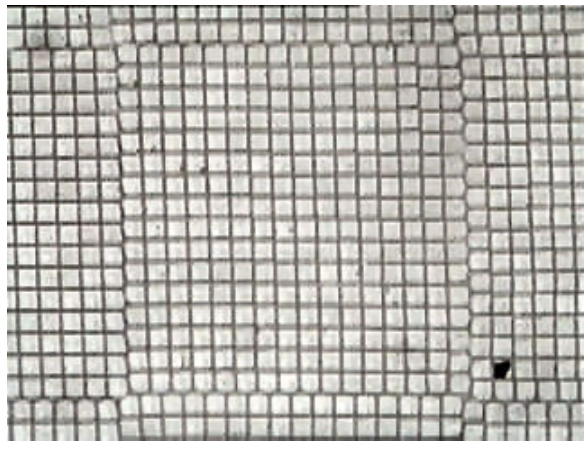
Fig. 6 . Optical microscope image of the prototype MCP optic showing the channel structure. Fig. 6. Optical microscope image of the prototype MCP optic show- ing the channel structure. The channel side length is 84 ± 2 µ m. The channel side length is 84 ± 2 µ m.